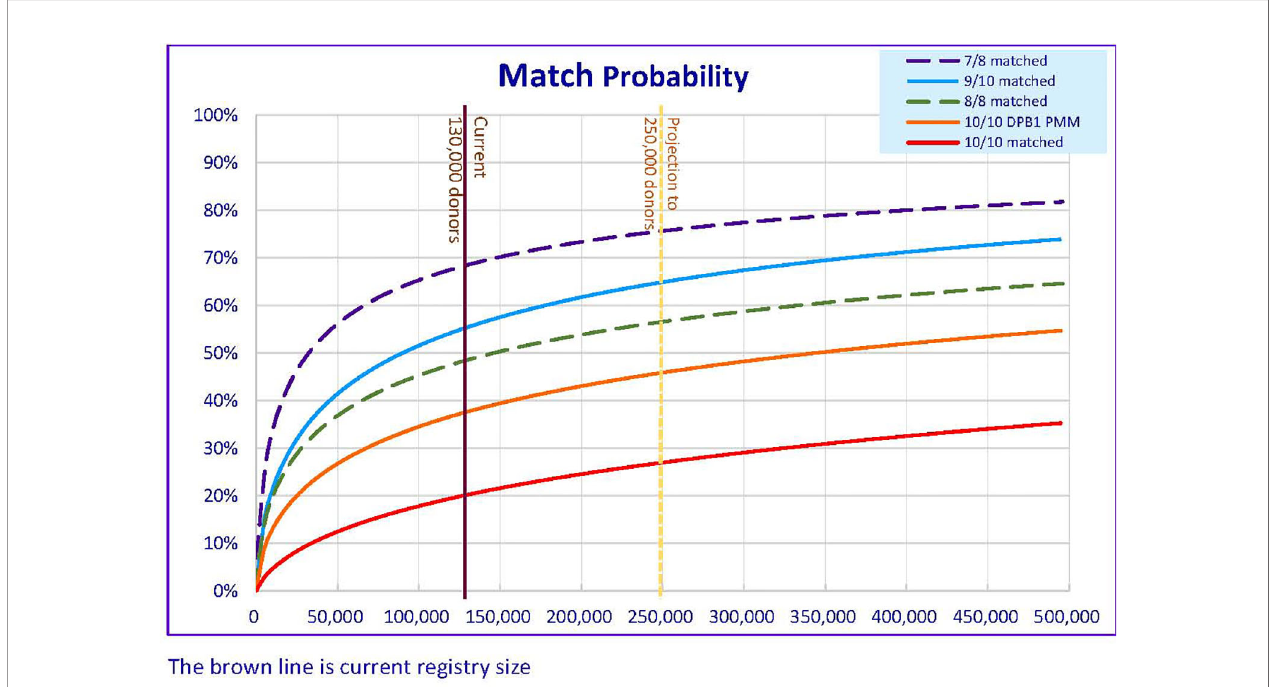
FIGURE 1 | Matching Probability (MP) of varies levelof HLAmatch against different donor registrysize in HKBMDR.DPB1 PMM – with HLA-DPB1 permissive mismatch.